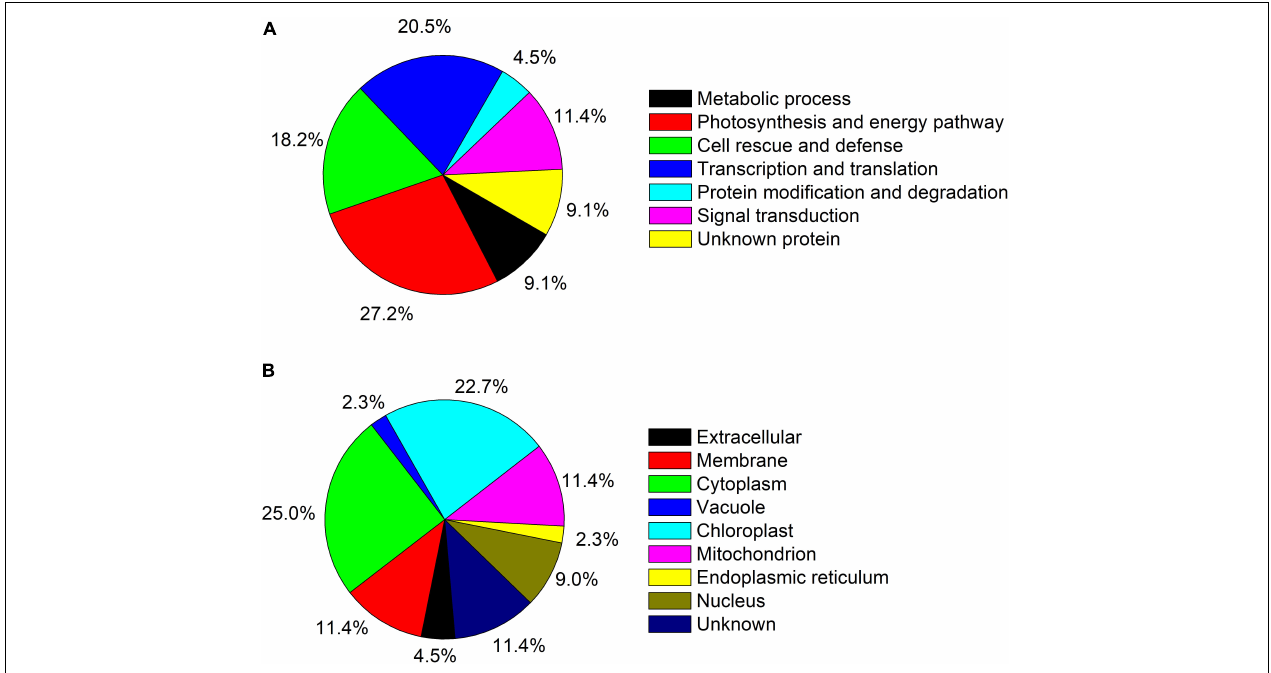
FIGURE 4 | (A) Functional category distribution of the identified proteins in AR-treated T. wallichiana var. mairei at low, medium, and high Ca levels. (B) Protein subcellular locations of all 44 identified and quantified proteins in AR-treated T. wallichiana var. mairei at low, medium, and high Ca